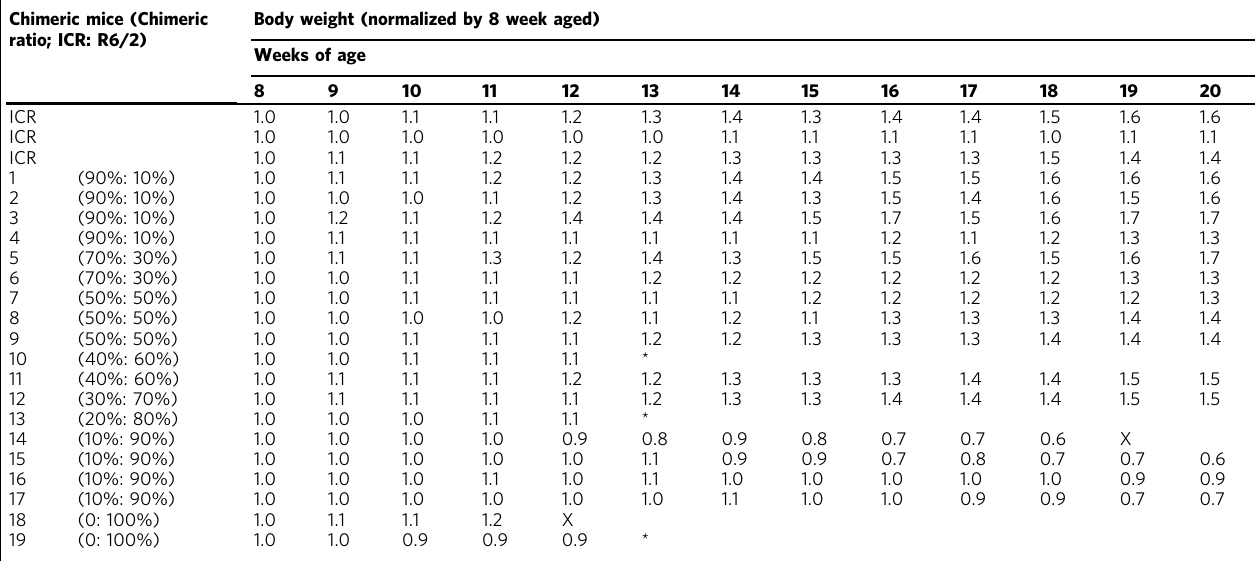
Table 1 Body weight of chimeric mice was normalized by body weight at 8 week old for comparison. Chimeric mice (Chimeric ratio; ICR: